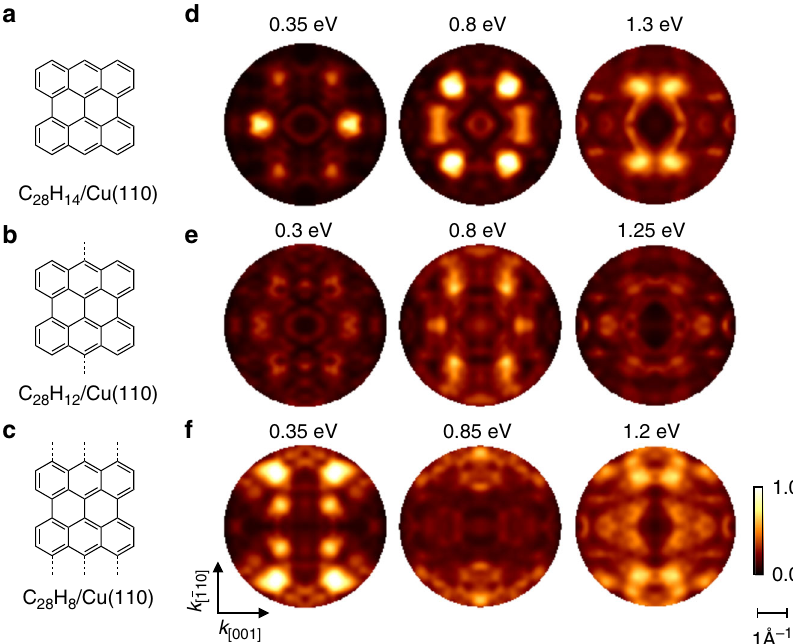
Fig. 4 Bisanthene, C 28 H 12 and C 28 H 8 on the Cu(110) surface. a – c Chemical structure and d – f simulated k -maps at three representative binding energies (compare dotted lines in Fig. 3c) for a , d bisanthene C 28 H 14 and partly dehydrogenated b , e C 28 H 12 and c , f C 28 H 8 . Grey dashed lines in b , c mark